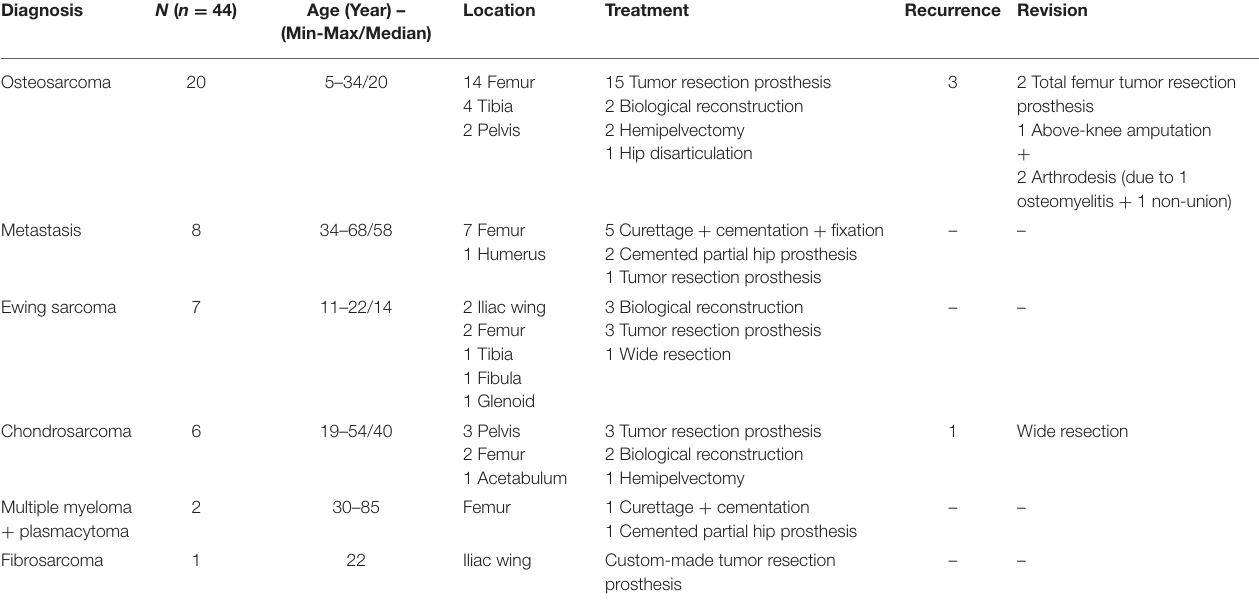
TABLE 9 | Malignant bone tumors of the lower extremity. Diagnosis